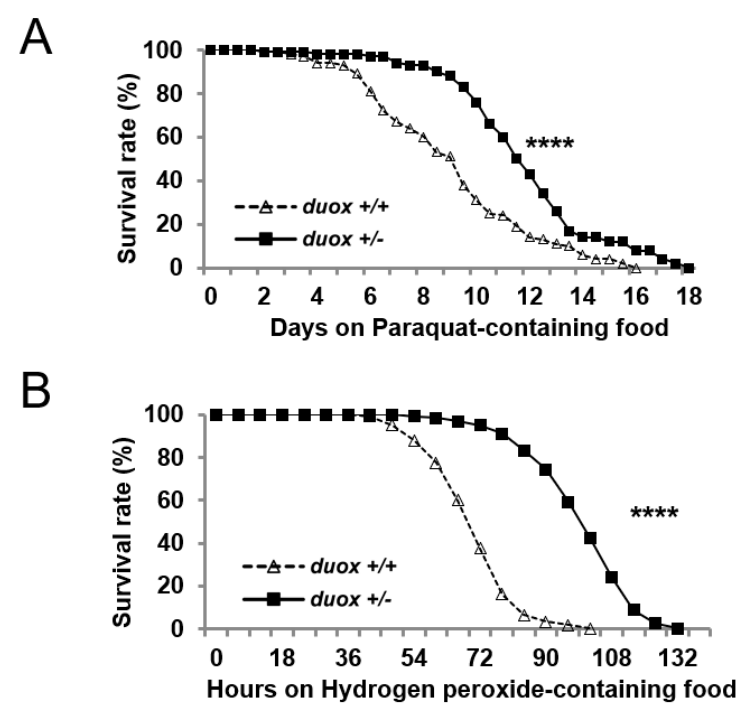
Figure 4. ROS resistance associated with duox heterozygosity. Survival of 5-day-old male flies on food containing 10 mM paraquat ( A ) and 10% hydrogen peroxide (H 2 O 2 ) ( B ). n = 200 (20 flies/vial, total 10 vials). Log-rank test, **** p < 0.0001. duox +/+ denotes w 1118 flies. duox +/ − denotes duox +/kG07745 flies, which were isogenized ten times with control flies ( w 1118 ).